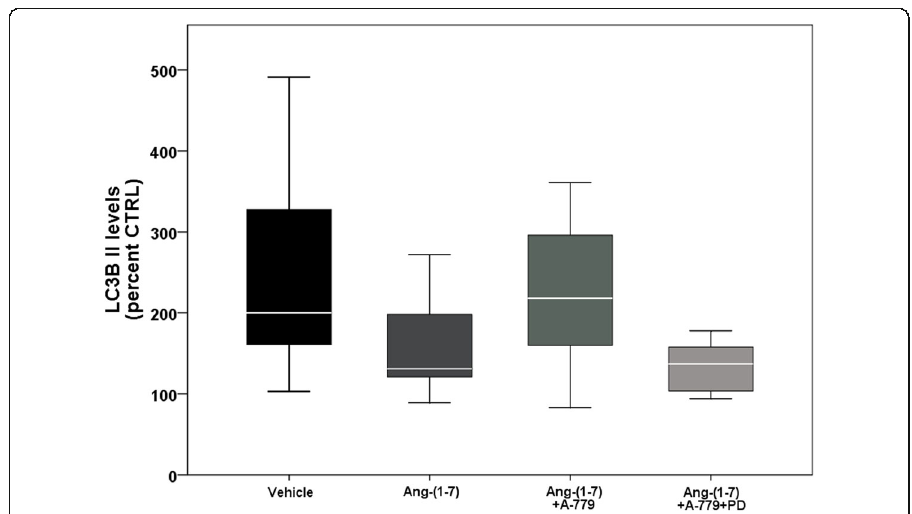
Fig. 4 Western blot analysis: autophagy-related protein (LC3B II). Vehicle ( n = 11): VIDD + saline treatment; Ang-(1 – 7) ( n = 10): VIDD + Ang-(1 – 7) treatment; Ang-(1 – 7) + A-779 ( n = 9): VIDD + Ang-(1 – 7) + A-779 treatment; Ang-(1 – 7) + A-779 + PD ( n = 7): VIDD + Ang-(1 – 7) + A-779 + PD123319